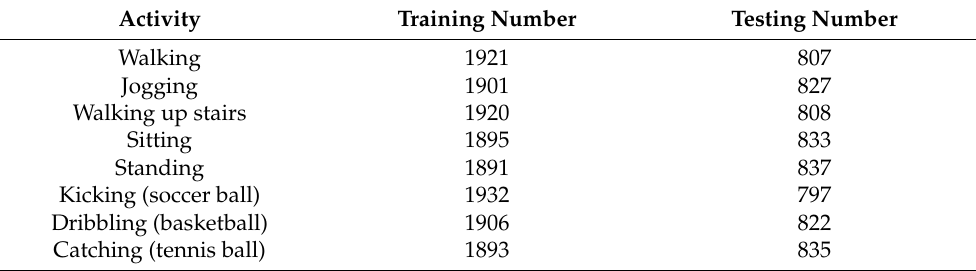
Table 1. Sample numbers of eighteen activities for model training and testing with the UCI-WISDM